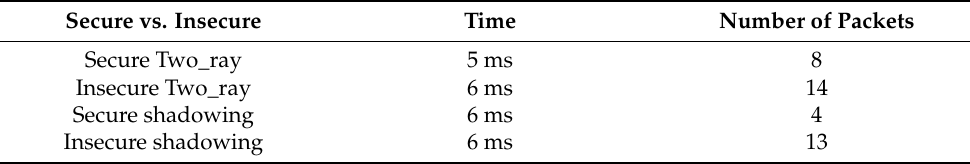
Table 5. The number of packets versus time in packet loss parameter. Secure vs.